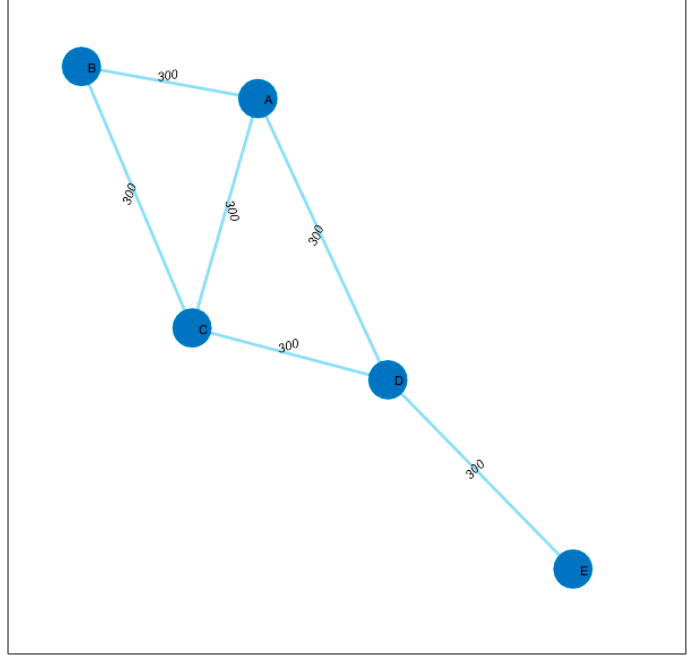
Figure 1. Graph of a 5-country coalitional game.